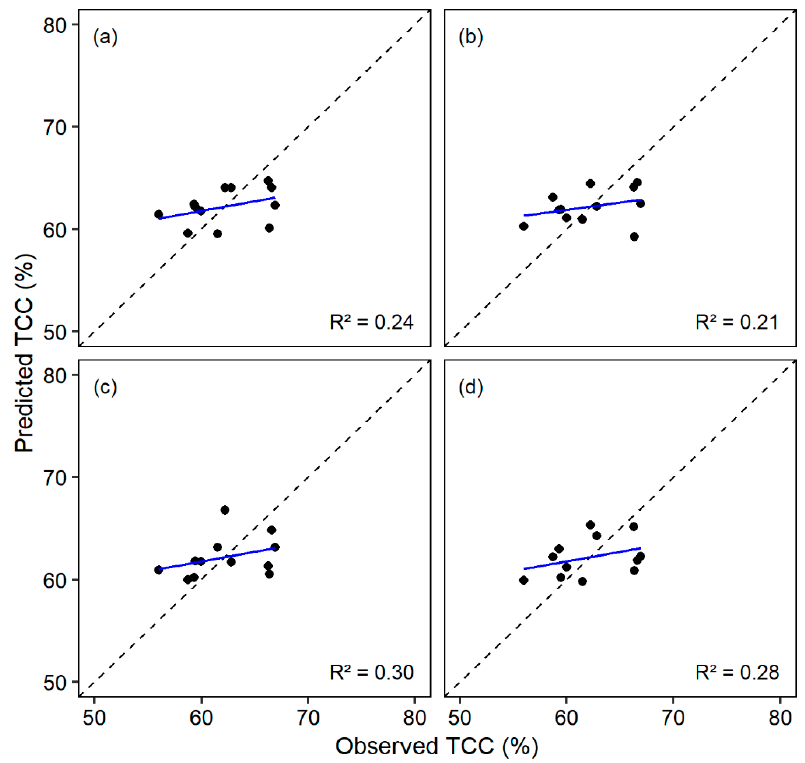
Figure 4. Relationship between the observed and predicted TCC for the first (a), second (b), third (c), and fourth (d)